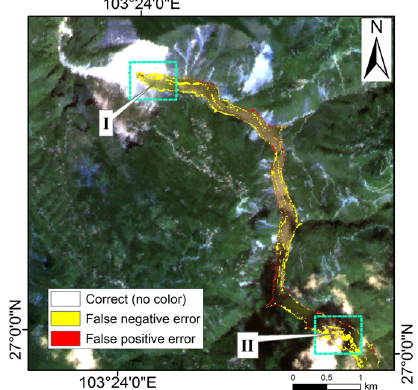
Figure 5. Location of change detection errors in the result of the proposed method.